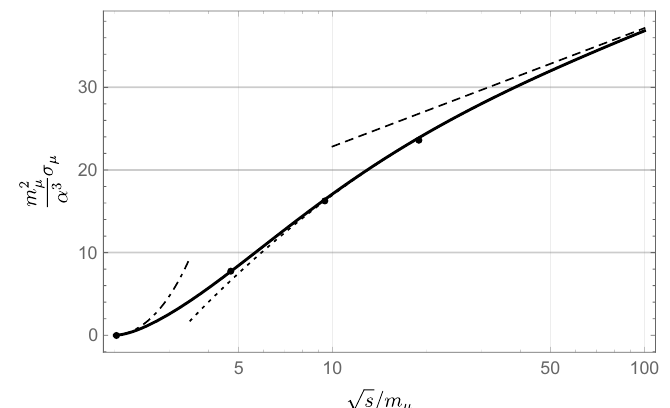
Figure 2. Exact cross-section of the e − γ → e − µ + µ − (solid curve) and asymptotics. Black dashed curve — leading asymptotic, dotted curve — eq. (2.14), and dash-dotted curve — the cross-section near threshold, eq. (2.13). Points represent the data obtained by numerical Monte-Carlo integration of the differential cross section using Cuba